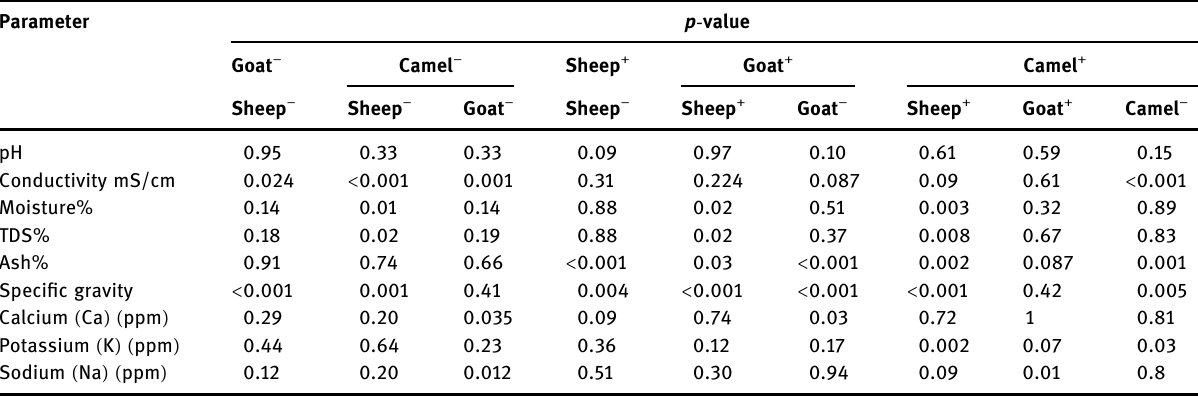
Table 2: The variations between the mean values of the studied parameters in the di ff erent study groups using the LSD post hoc test of ANOVA test